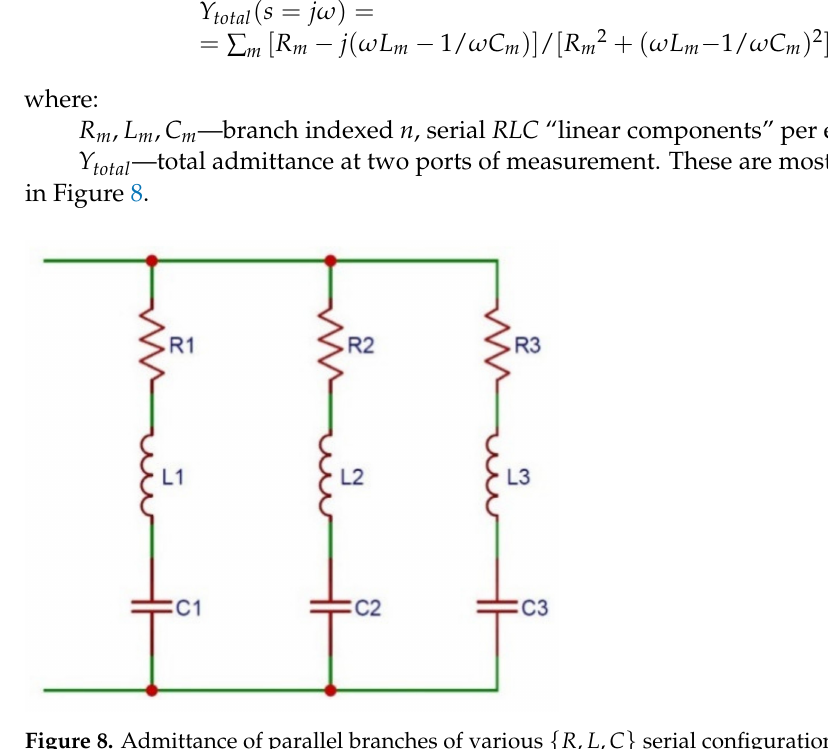
Figure 8. Admittance of parallel branches of various { R , L , C } serial configuration